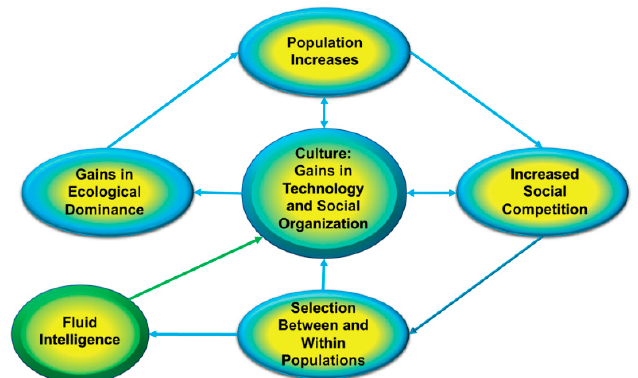
Figure 2. A cyclical within-species arms race is the most plausible account of the evolutionary enlargement of the human brain and enhancement in fluid intelligence.